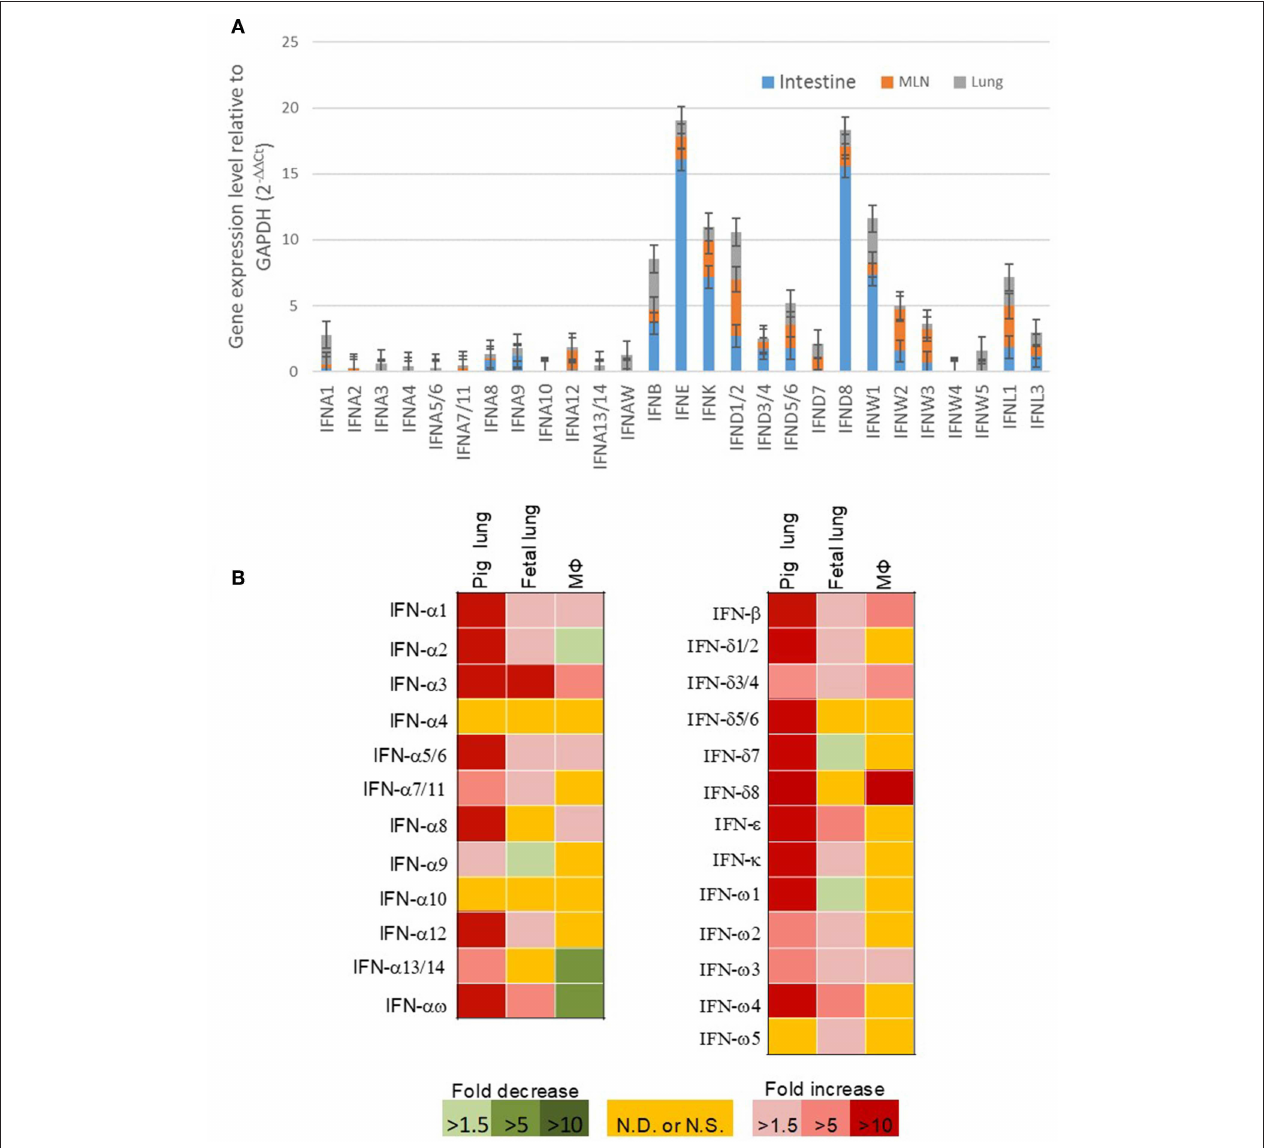
FIGURE 5 | (A) Relative gene expression of porcine type I IFNs in the intestine, mesenteric lymph nodes, and lung from normal 5-week-old pigs. Real time RT-PCR assays were conducted as in Manry et al. (7), basal expression of IFN genes was normalized against Ct values of a housekeeping gene (GAPDH) and presented as relative expression index. Compared with the genes of IFN- α subtype (gene symbol IFNA, and so on) that are mostly inductive, unconventional porcine type I IFN genes including IFNWs show much higher constitutive expression in mucosal tissues and lymph nodes. Data, n = 3 PCR repeats of tissue samples from 3 to 5 pigs. (B) Sub-optimal stimulation of porcine type I IFNs in PRRSV-exposed fetal lungs and alveolar macrophages (M Φ ). Lungs of fetuses and pregnant sows infected with PRRSV at the 90th of the gestation day, and porcine alveolar M Φ infected in vitro with PRRSV for 6h were evaluated for mRNA expression of IFNs. Data, n = 3 PCR repeats of tissue samples from 3 samples (9, 10, 13,